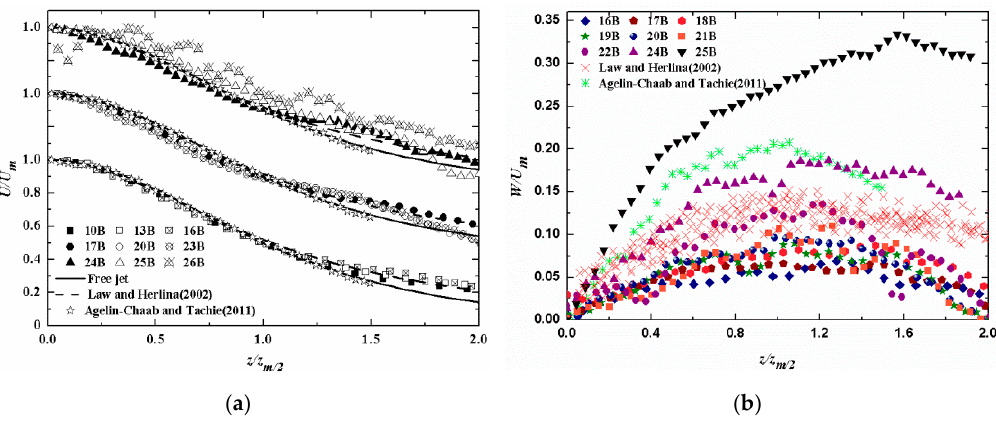
Figure 6. Mean velocity profiles measured in x - z plane for Re = 11,666: ( a ) U profiles, and ( b ) W profiles.